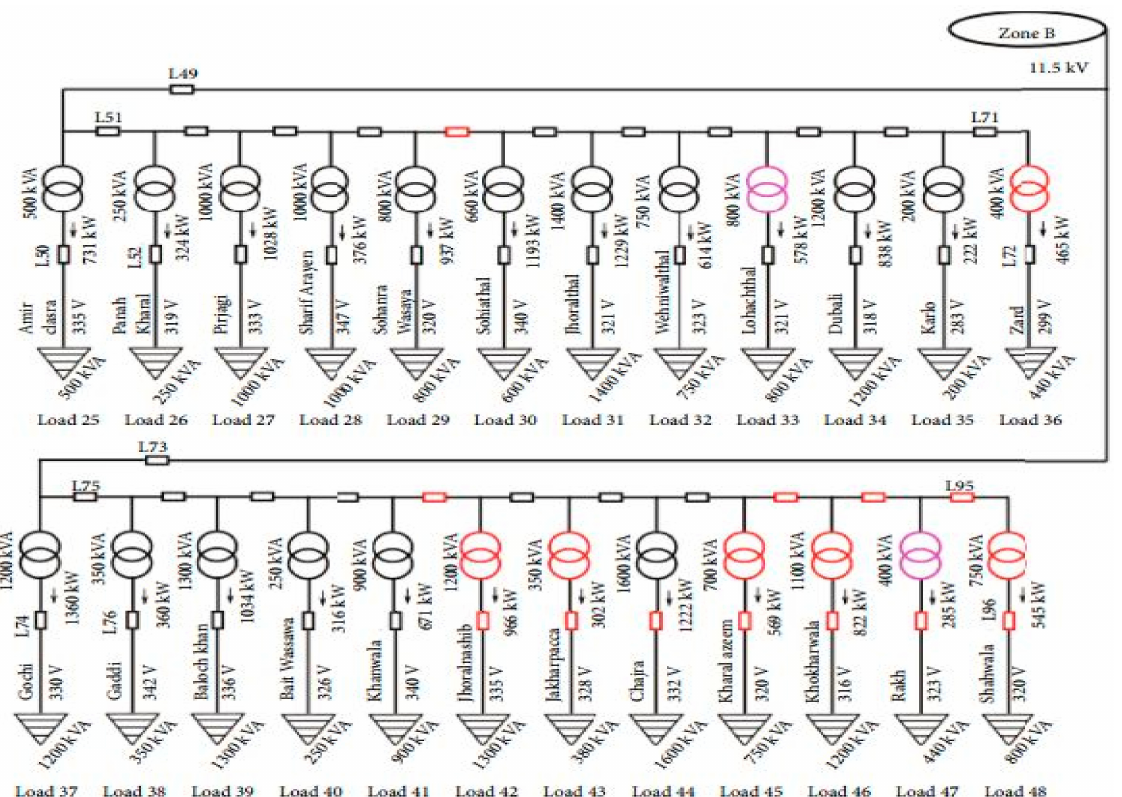
Figure 12. Grid with overloaded transformers and lines in red